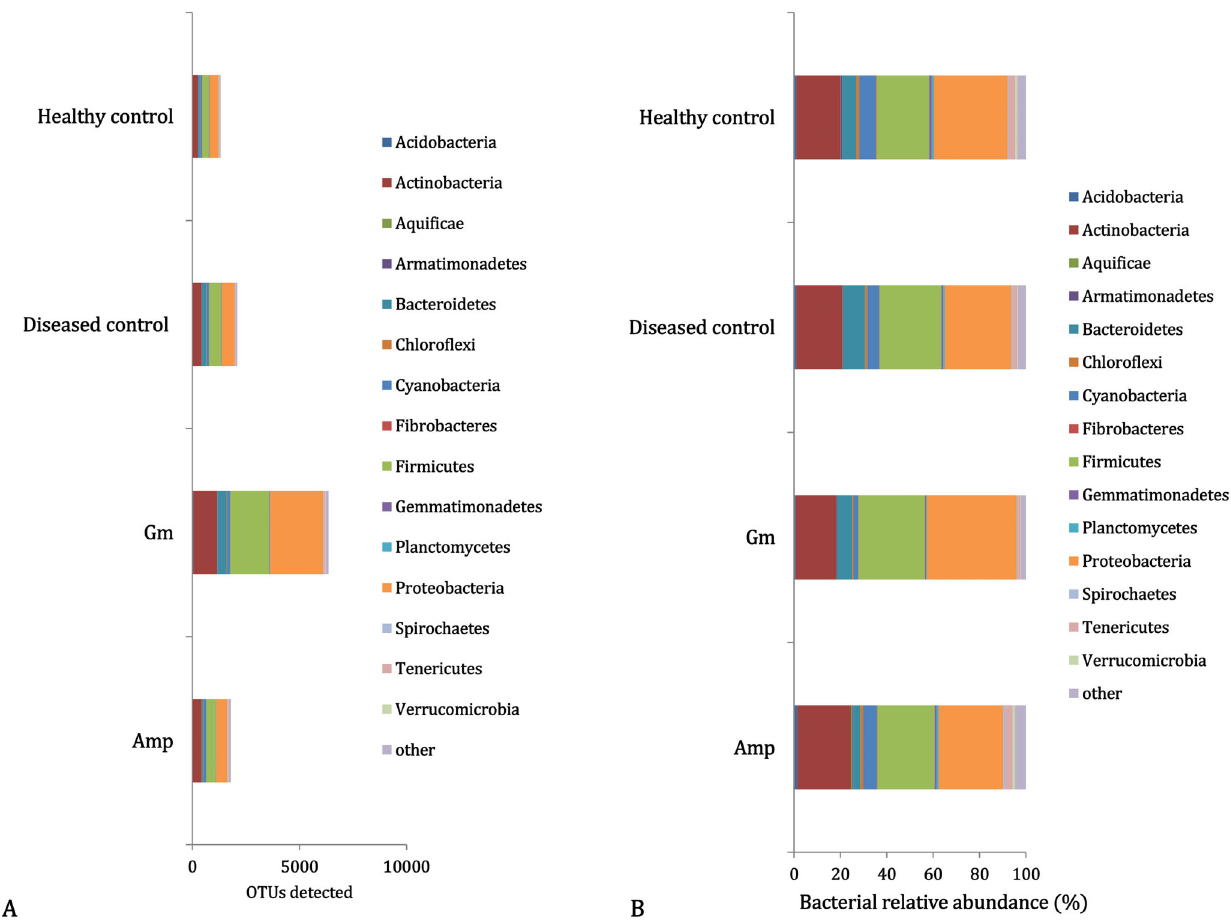
Figure 1. Bacterial community of leaf midribs of scions. A ) Composition and B ) relative abundance of the bacterial Operational Taxonomic Units (OTUs) present in leaf midribs of scions from grapefruit rootstocks grafted with HLB-affected lemon scions treated with ampicillin (Amp), gentamicin (Gm) and water (disease control; CK 1 ). The healthy plants were grafted using Las-free lemon scions (healthy control; CK 2 ).